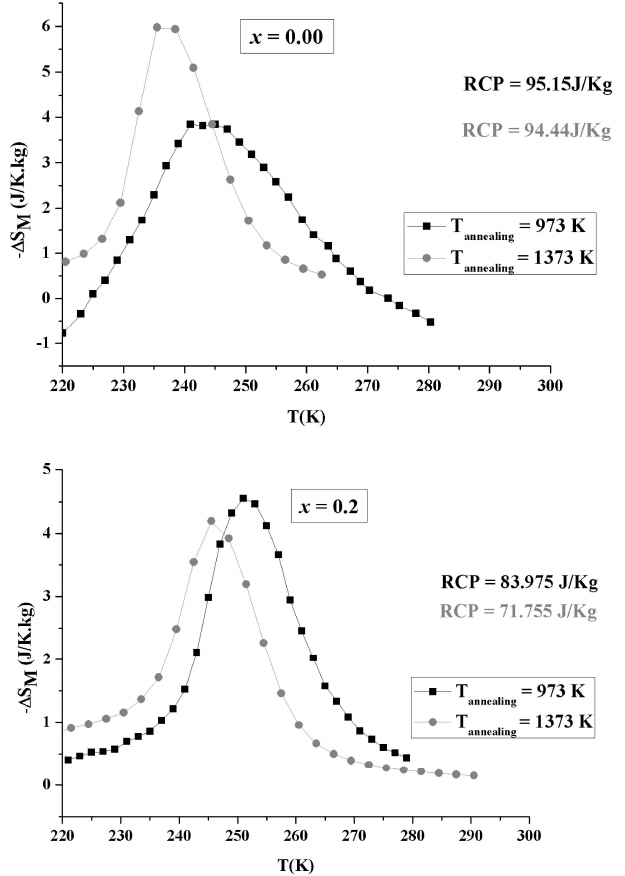
Figure 5. Temperature dependence of the magnetic entropy change ( −Δ S M ) measured for an applied magnetic field of 2 T for x = 0.00 and 0.2 samples annealed at 1373 and 773K. RCP: relative cooling power.